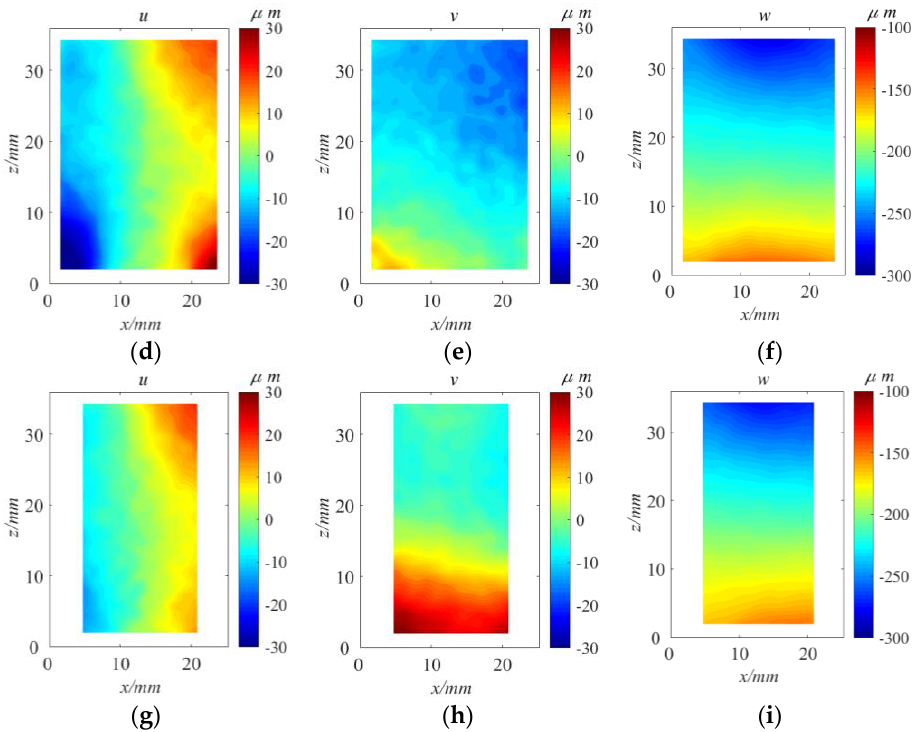
Figure 4. Contour plots of displacement values u , v and w of the sections of step 6: ( a – c ) along y = 6.20 mm, respectively; ( d – f ) along y = 12.50 mm, respectively; ( g – i ) along y = 18.80 mm, respectively.